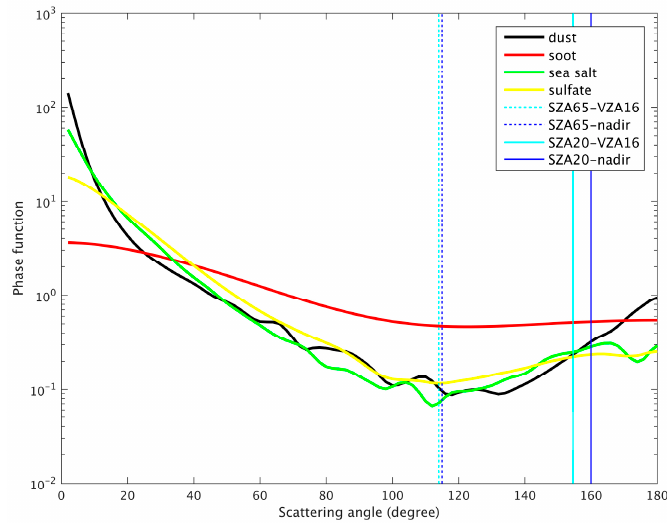
Figure 2. Scattering phase functions of four aerosol types used in this study. Black, red, green and yellow thick solid lines represent the scattering phase function of dust, soot, sea salt and sulfate. Scattering angles corresponding to different solar zenith angles and viewing zenith angles are indicated by cyan and blue thin solid or dashed lines, respectively. VZA, viewing zenith angle.